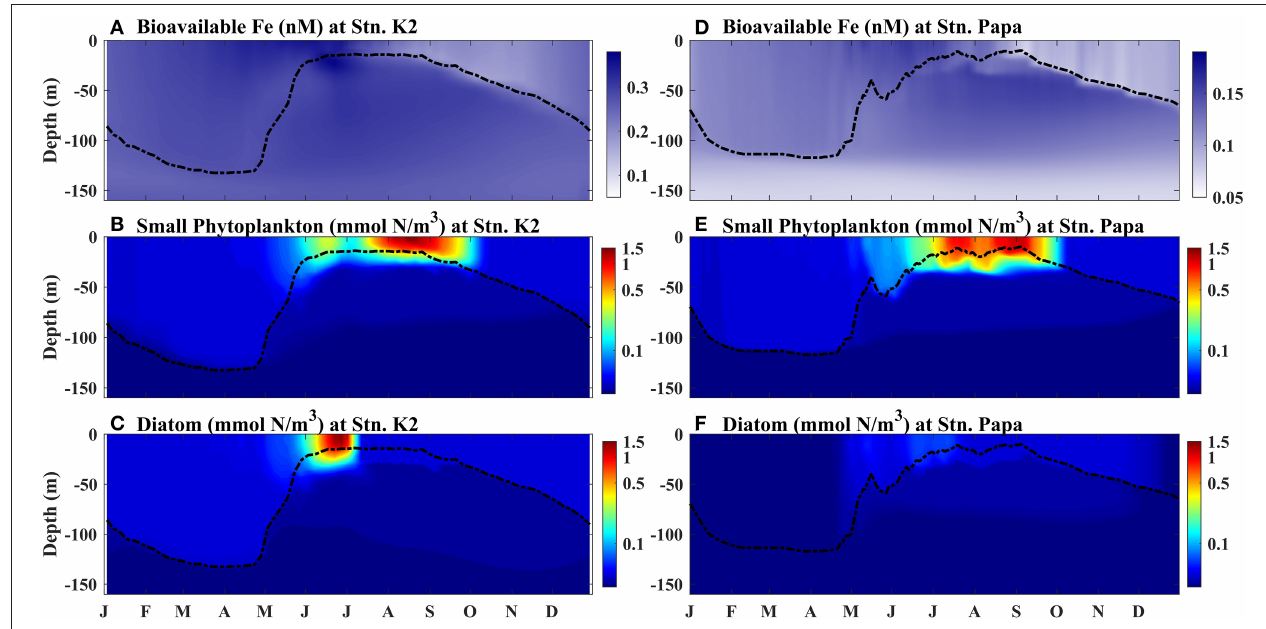
FIGURE 4 | Modeled seasonal cycle of vertical profiles at (A–C) Stn. K2 and (D–F) Stn. Papa. (A,D) Bioavailable Fe (B,E) , small phytoplankton biomass, and (C,F) diatom biomass. The black dashed lines represent the